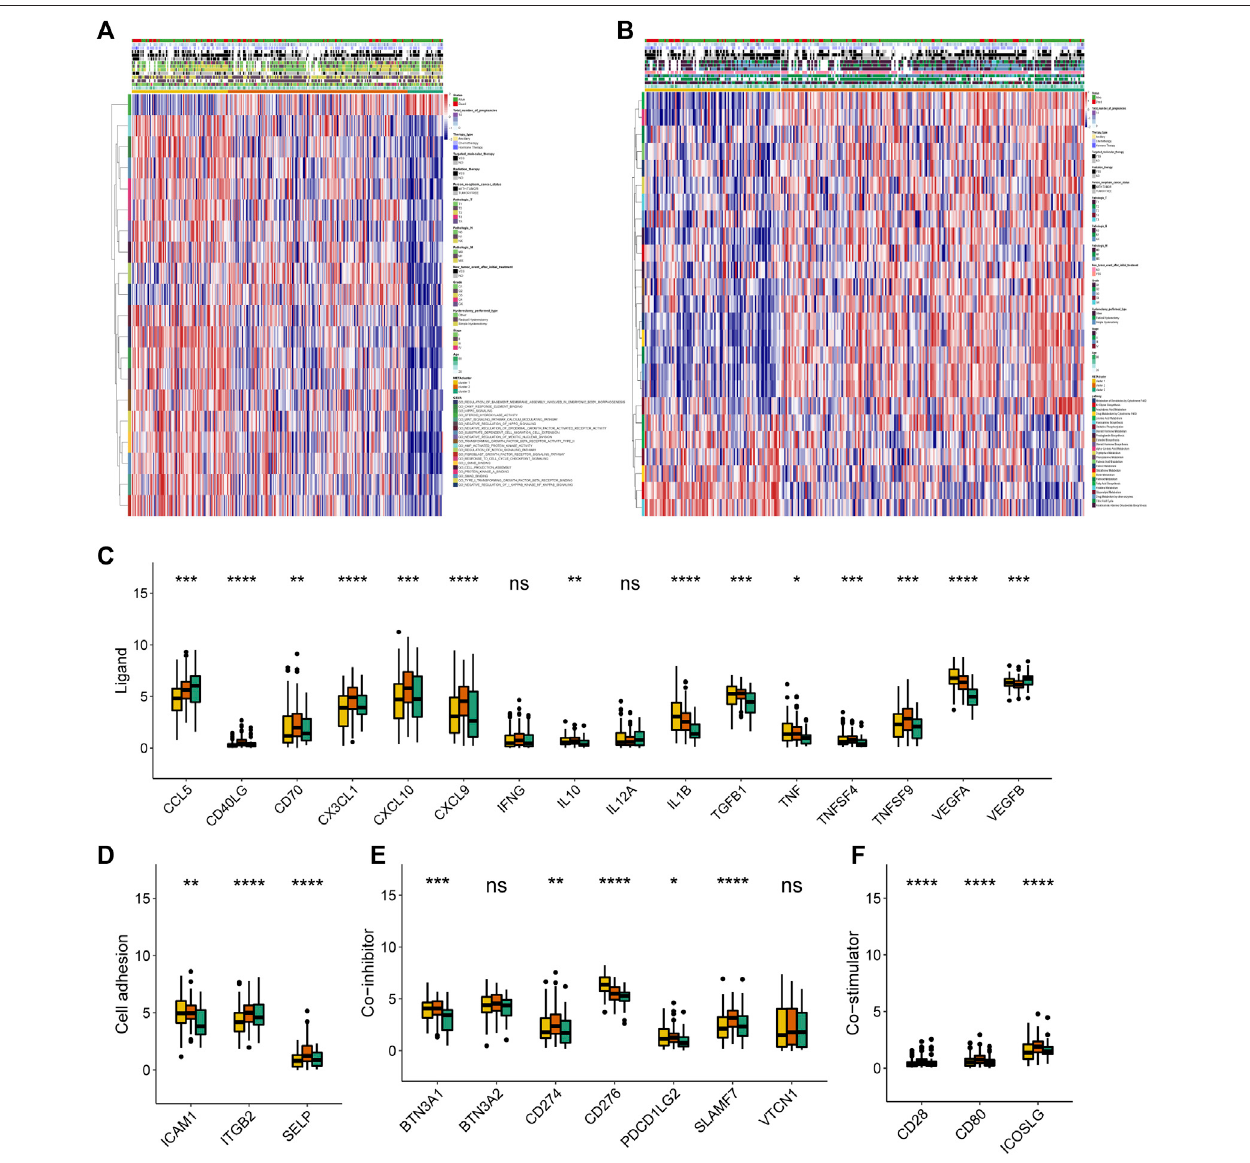
FIGURE 2 | Transcriptome, metabolic and immune characteristics of the three METAclusters. (A) Pathway enrichment analysis showing the differential activated transcriptome pathways in each METAcluster. (B) Pathway enrichment analysis showing the differential activated metabolic pathways in each METAcluster. Heatmaps were plotted to visualize the biological processes. (C – F) Immune checkpoints expression (normalized count) in each METAcluster. The statistical p value was represented by asterisks (ns represents no signi fi cance; * p < 0.05; ** p < 0.01; *** p < 0.001; **** p < 0.0001).